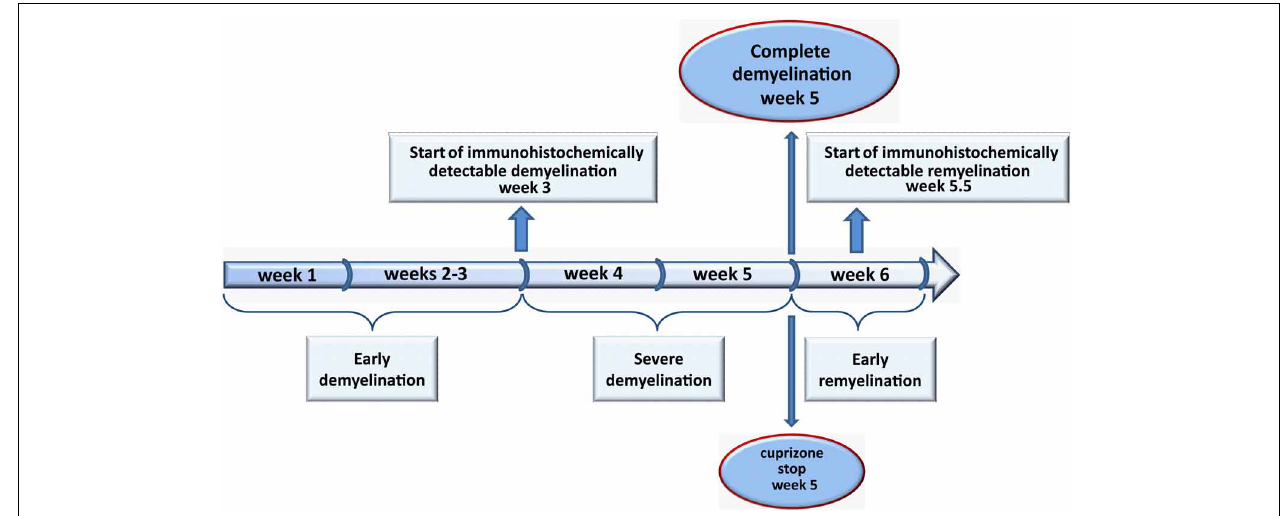
FIGURE 1 | The course of de- and remyelination in the medial corpus callosum. 8–10 weeks old C57BL/6 mice were fed with 0.2% (w/w) cuprizone for 5 weeks. During the “early demyelination” (1–3 weeks) the degradation of myelin proteins begins and can be hardly detectable using immunohistochemical techniques. After week 3 onwards demyelination progresses (“severe demyelination”) and is